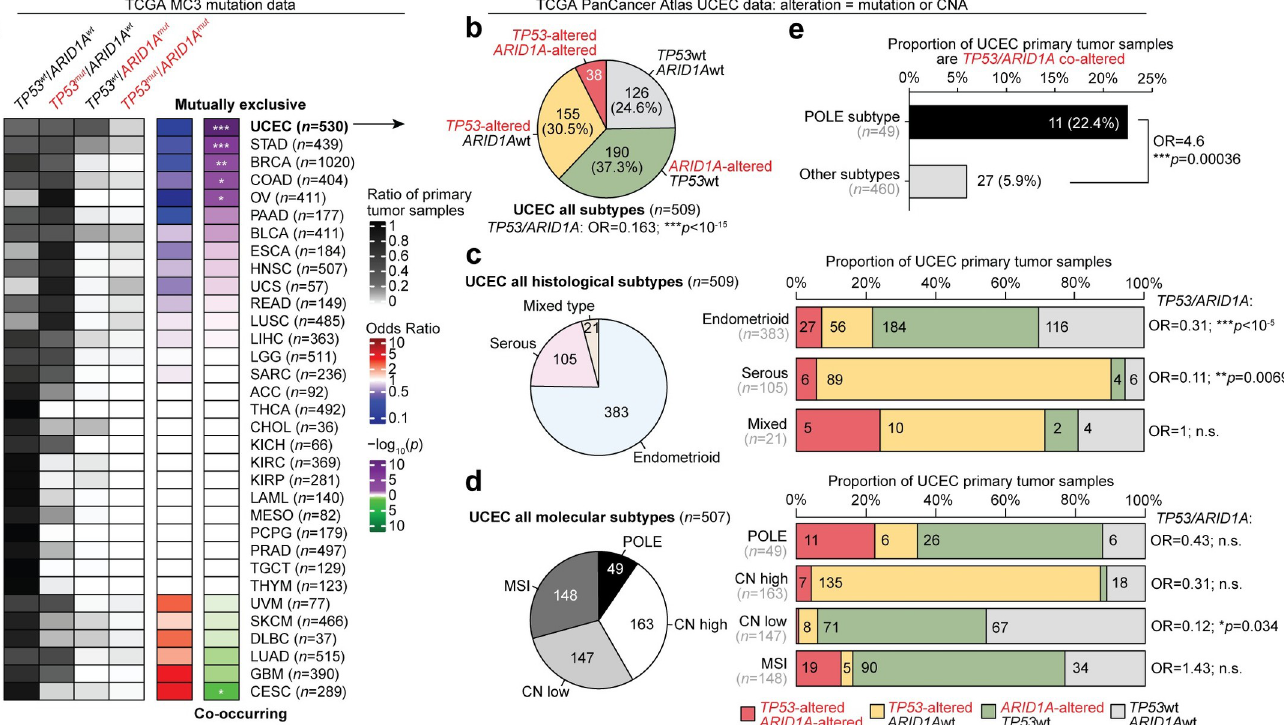
PLOS Genetics | https://doi.org/10.1371/journal.pgen.1009986 December 23,